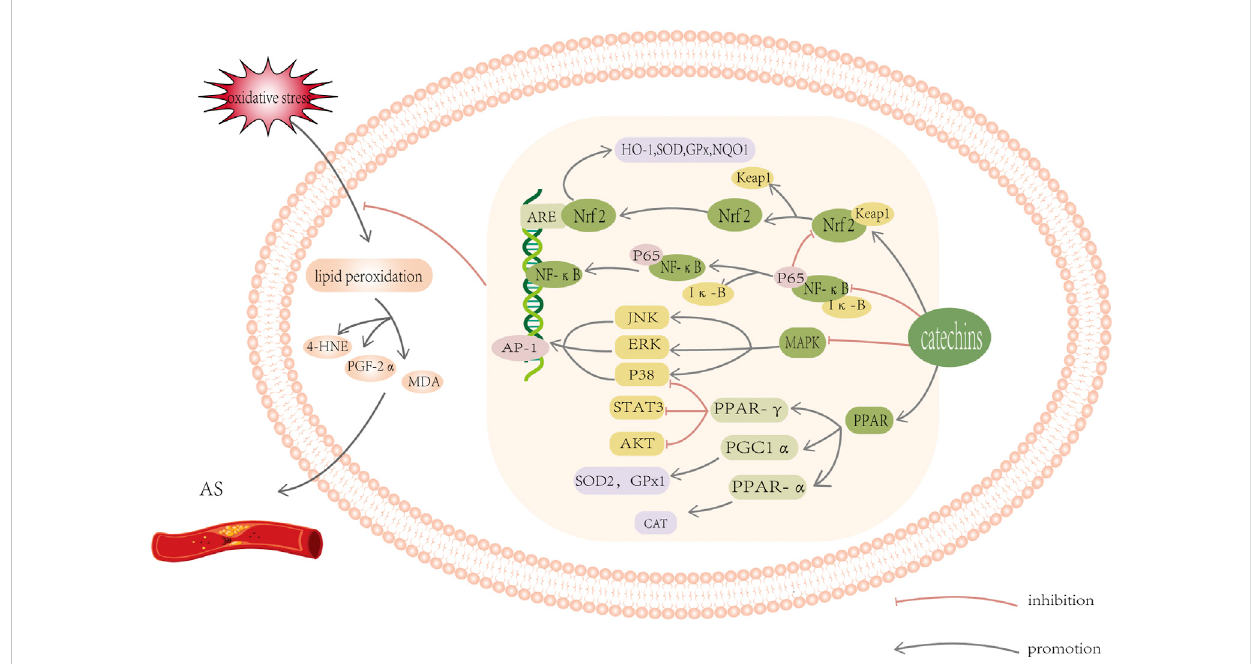
Schematic diagram of oxidative stress-related signal pathway. Catechins can induce the activation of Keap1/Nrf2/ARE signal pathway, inhibit the activation of MAPK/AP-1 pathway, and block the activation of transcription factor NF- κ B and increase PPAR γ , PGC1 a And PPAR a Protein level. These reactions all work together to help reduce oxidative stress and lipid peroxidation. For detailed explanation, please see